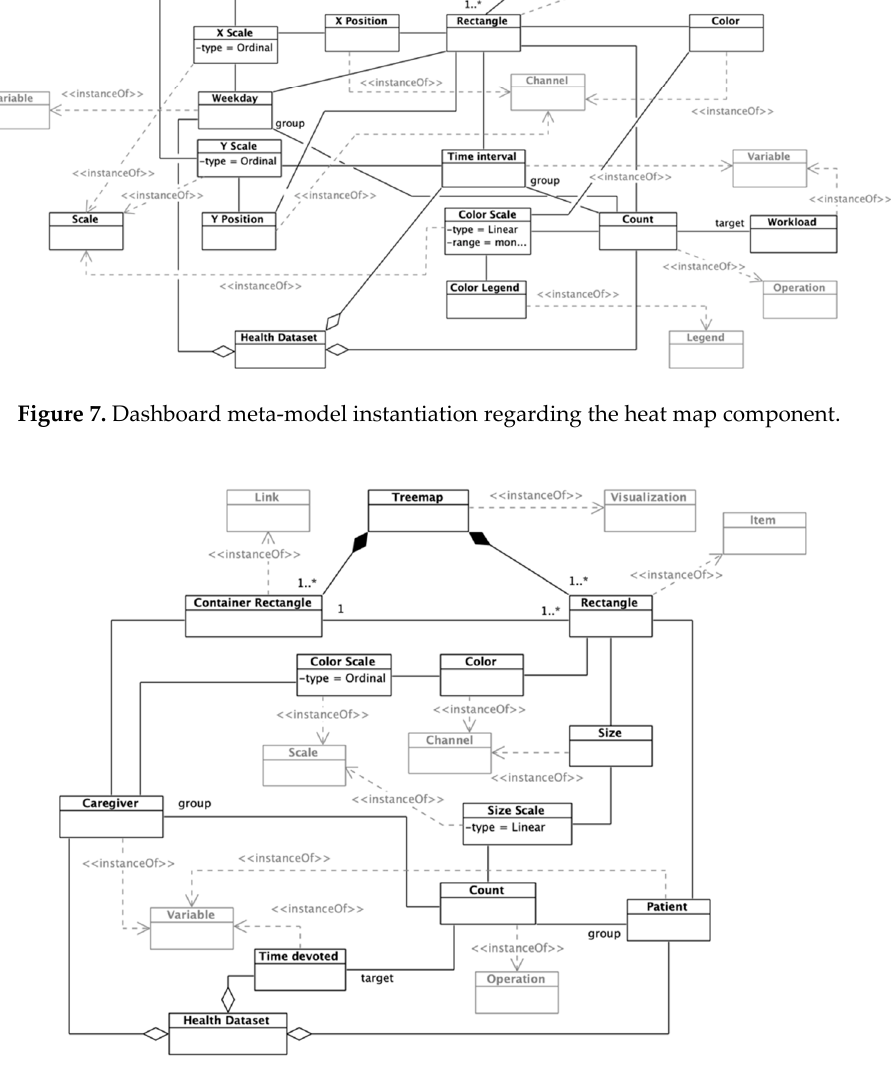
Figure 8. Dashboard meta-model instantiation regarding the treemap